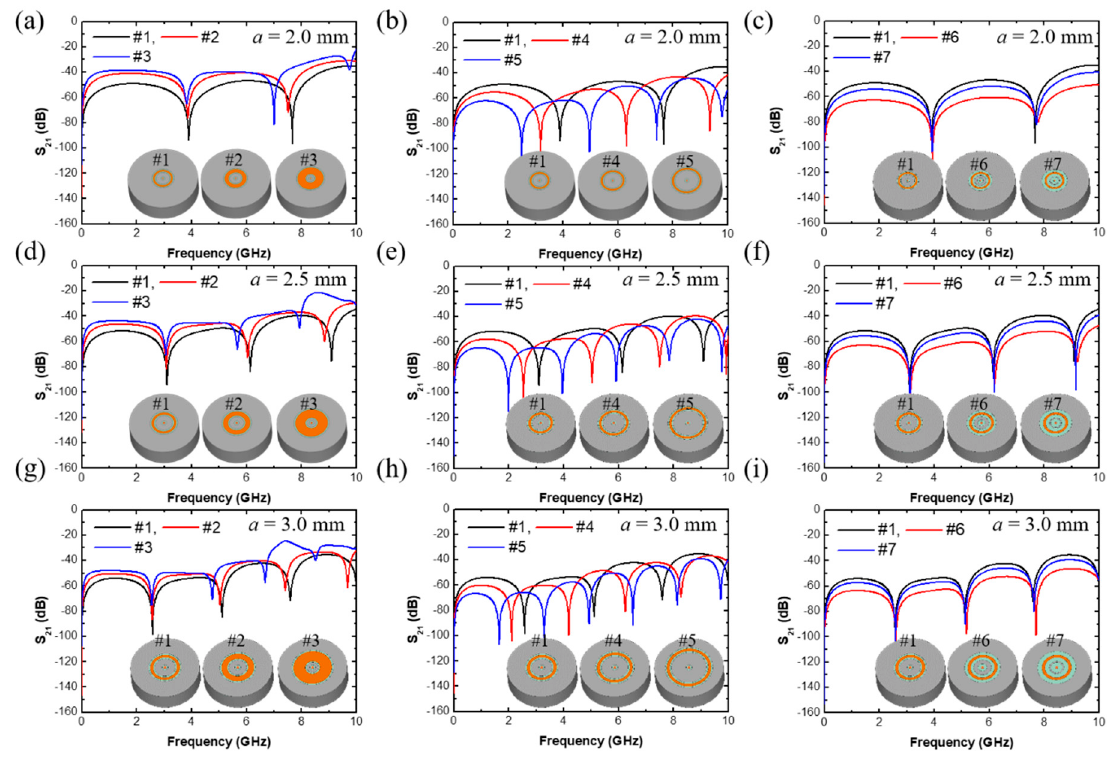
Figure 2. S 21 spectra of the RCP from various ( a , d , g ) antenna widths, ( b , e , h ) antenna distances, and ( c , f , i ) dielectric thickness at various antenna diameters: ( a – c ) a = 2.0 mm, ( d – f ) a = 2.5 mm, and ( g – i ) a = 3.0 mm.